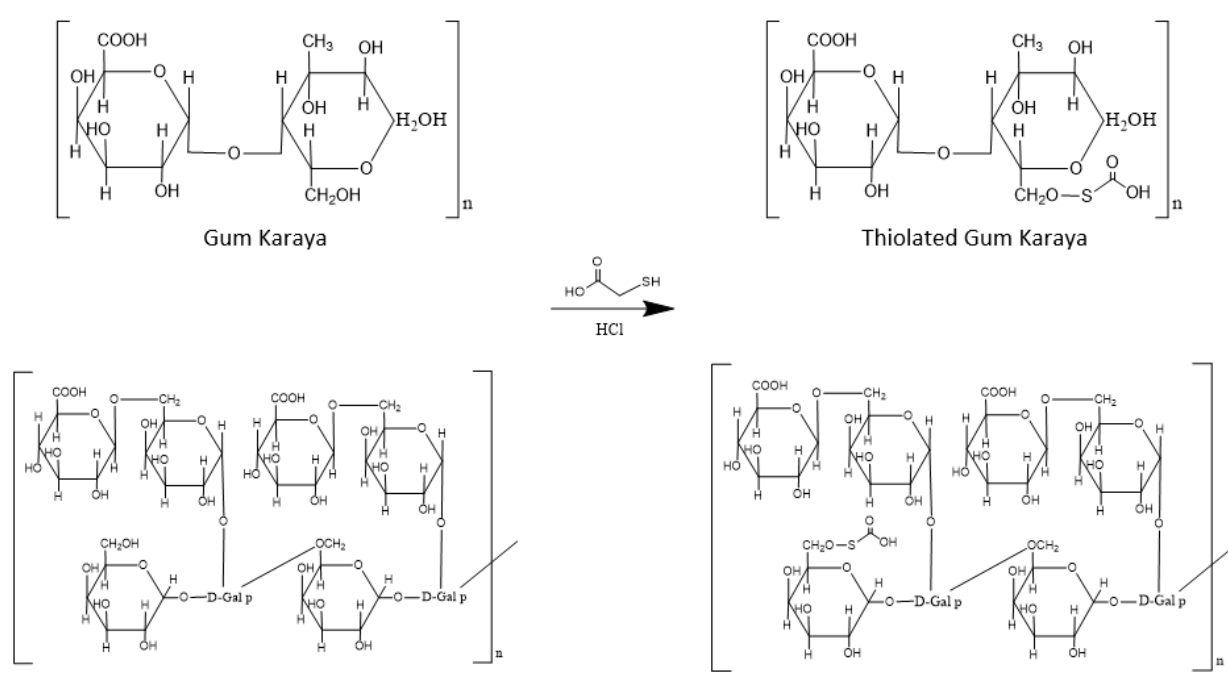
Figure 1. The synthesis of thiolated gum Karaya and Acacia.